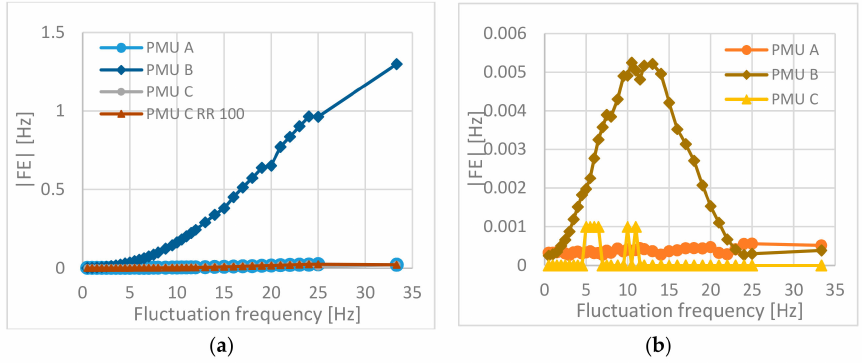
Figure 10. FE results for the PMUs with P ( a ) and M ( b ) configuration.